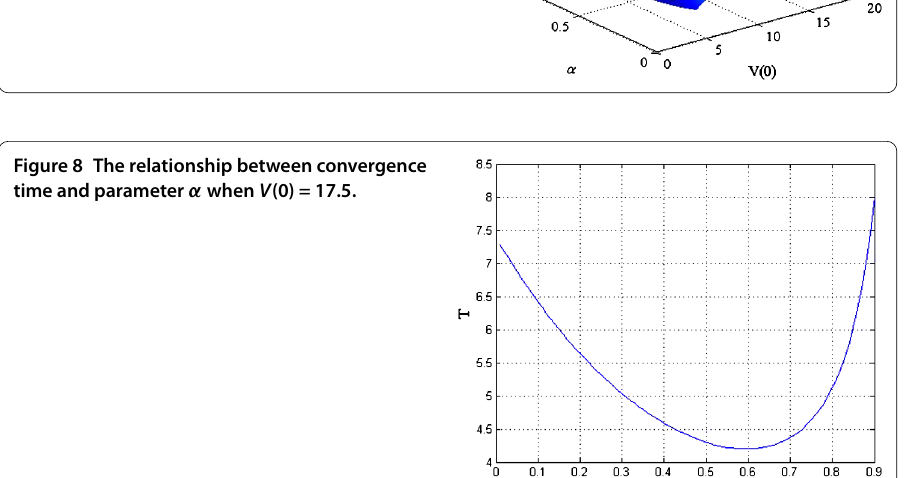
and α when V () = . (the corresponding V () for x () in this paper) is shown in Fig- ure . The two figures show that if V () λ  ( D ) > E  /, then the convergence time decreases initially, then increases as α becomes large, and when α =  – / ln ( V () λ  ( D )), the con- vergence time gets the minimum